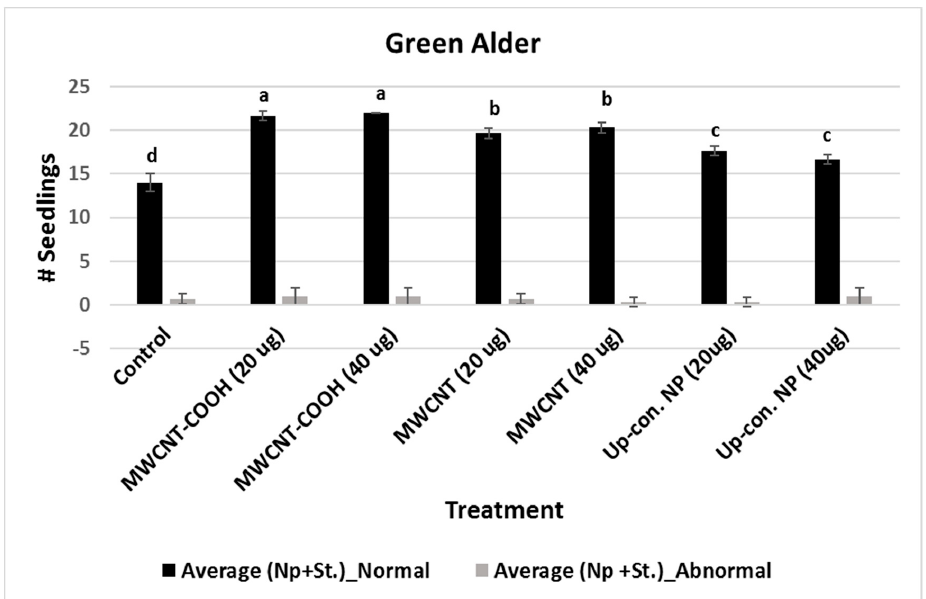
Figure 4. Effects of different priming treatments on number of normal and abnormal seedlings in green Figure 4. E ff ects of di ff erent priming treatments on number of normal and abnormal seedlings in green alder. Each bar represents the number of seedlings ± standard errors. Different letters on vertical bars alder. Each bar represents the number of seedlings ± standard errors. Di ff erent letters on vertical bars indicate significant differences at α = 0.05. Control = no CNPs added, MWCNT–COOH = multiwall carbon indicate significant di ff erences at α = 0.05. Control = no CNPs added, MWCNT–COOH =